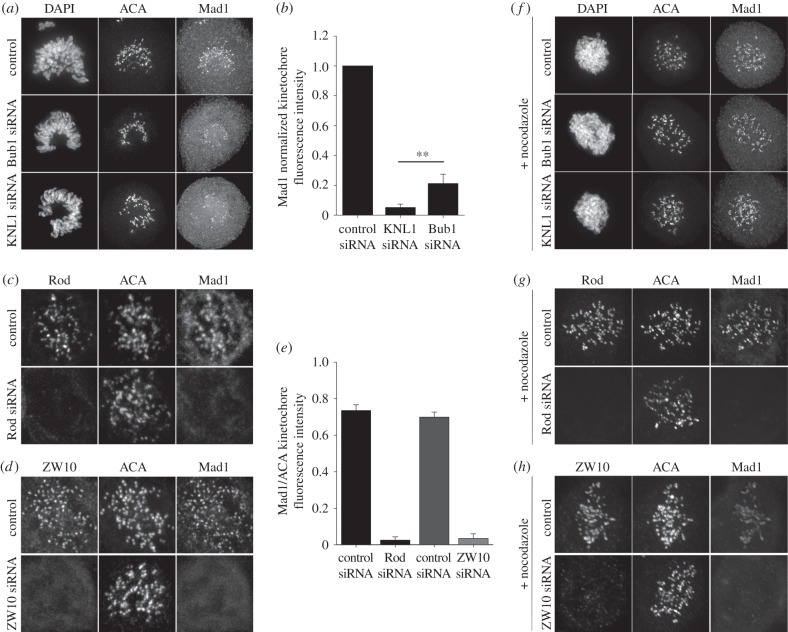
The RZZ complex is critical for Mad1 kinetochore localization. HeLa cells depleted of (a,f, middle row) Bub1, (a,f, bottom row) KNL1, (c,g) Rod and (d,h) ZW10 were stained for ACA, Mad1 and (a,f) DAPI, (c,g) Rod or (d,h) ZW10, as indicated. The controls for each experiment are shown in the top rows for each panel, and the nocodazole-treated samples are shown in panels (f–h) (all rows). (b,e) Normalized Mad1 kinetochore fluorescence intensity was measured in control cells and those treated with the respective siRNAs as indicated in the bar graph. Error bars represent s.d. between experiments. (b) n > 182 kinetochores, n > 7 cells per experiment, n = 3 independent experiments, **p < 0.05 (Student's t-test). (e) n = 76 kinetochores, n = 3 cells per experiment, n = 2 independent experiments for Rod siRNA, n = 58 kinetochores, n = 3 cells per experiment and n = 2 independent experiments for ZW10 siRNA.